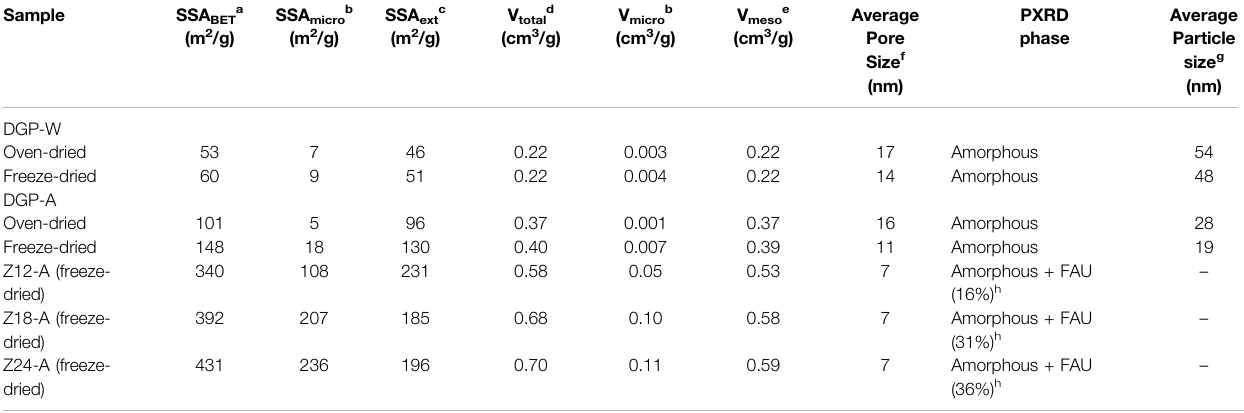
TABLE 1 | Selected properties of dispersible geopolymer particles obtained from various synthetic conditions. Sample